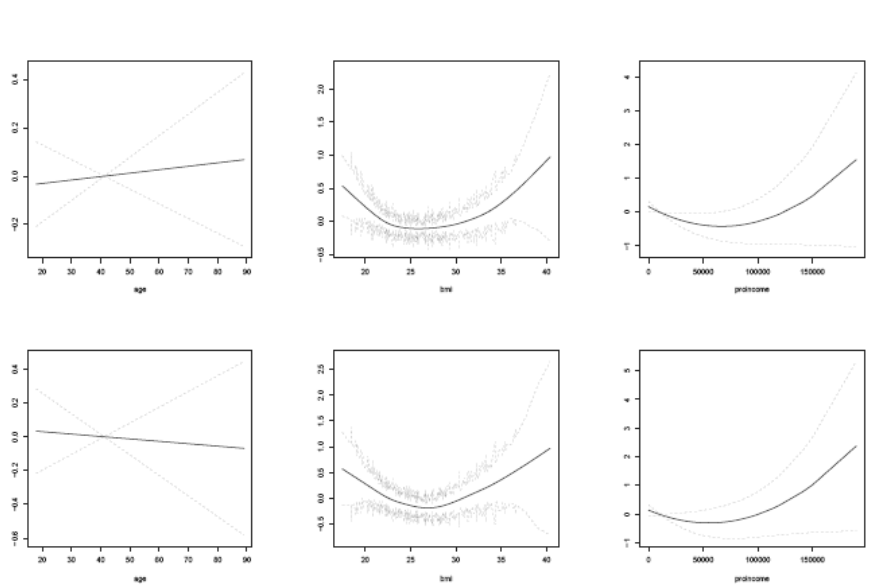
Figure 6 – Contributions to the linear predictor for  in the Poisson model M 2 (top row) and in the Negative Binomial model M 3 (bottom row).